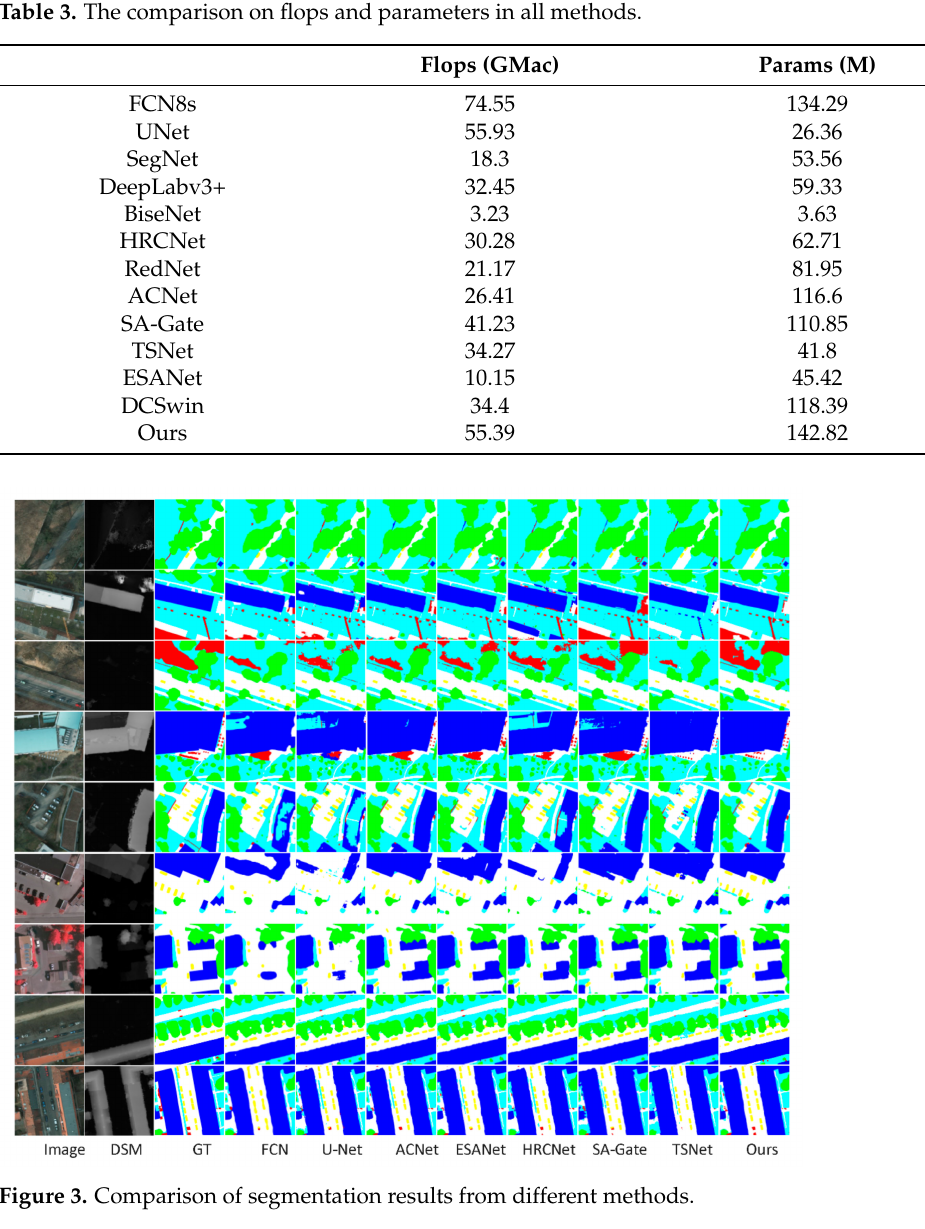
Table 3. The comparison on flops and parameters in all methods.